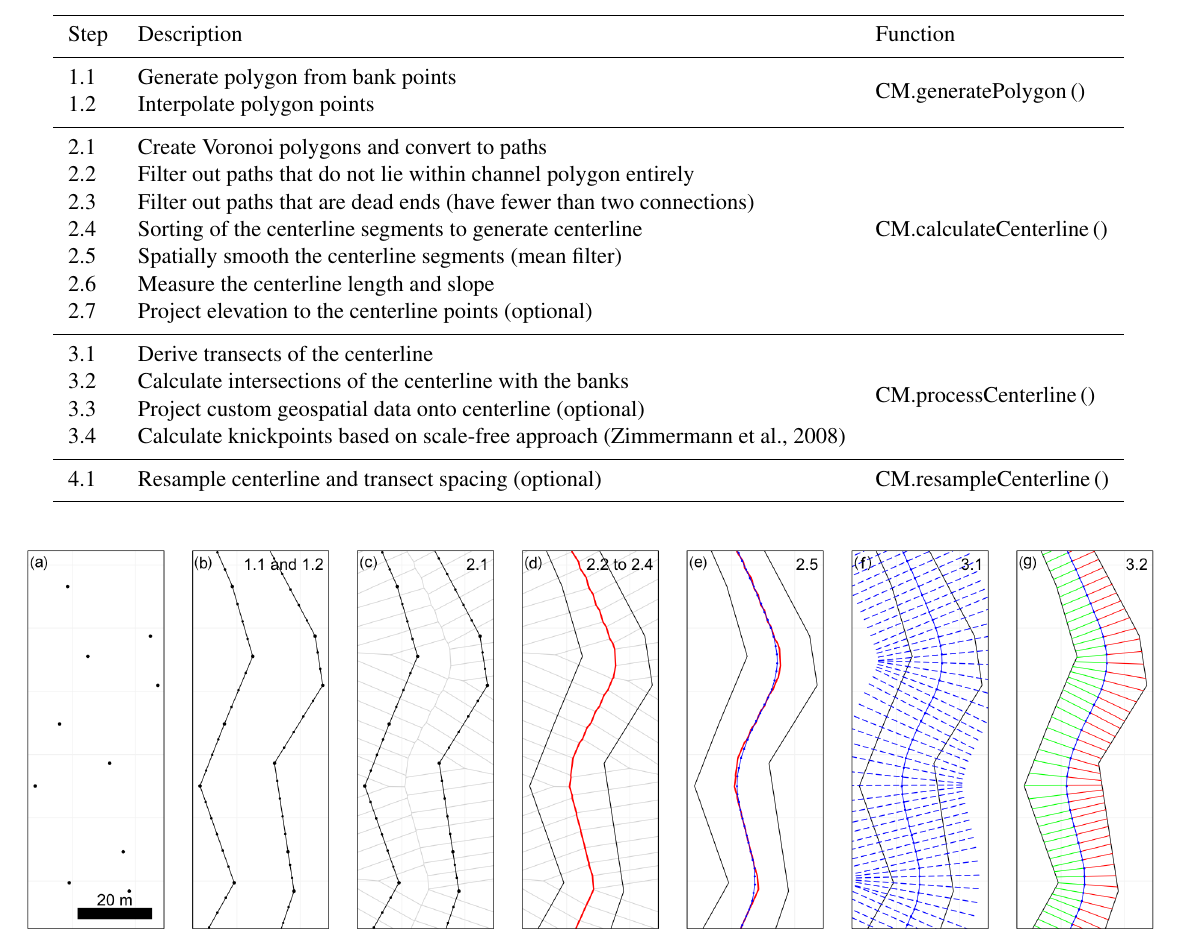
Table 2. Full list of steps for the algorithm of the cmgo package and their functions.